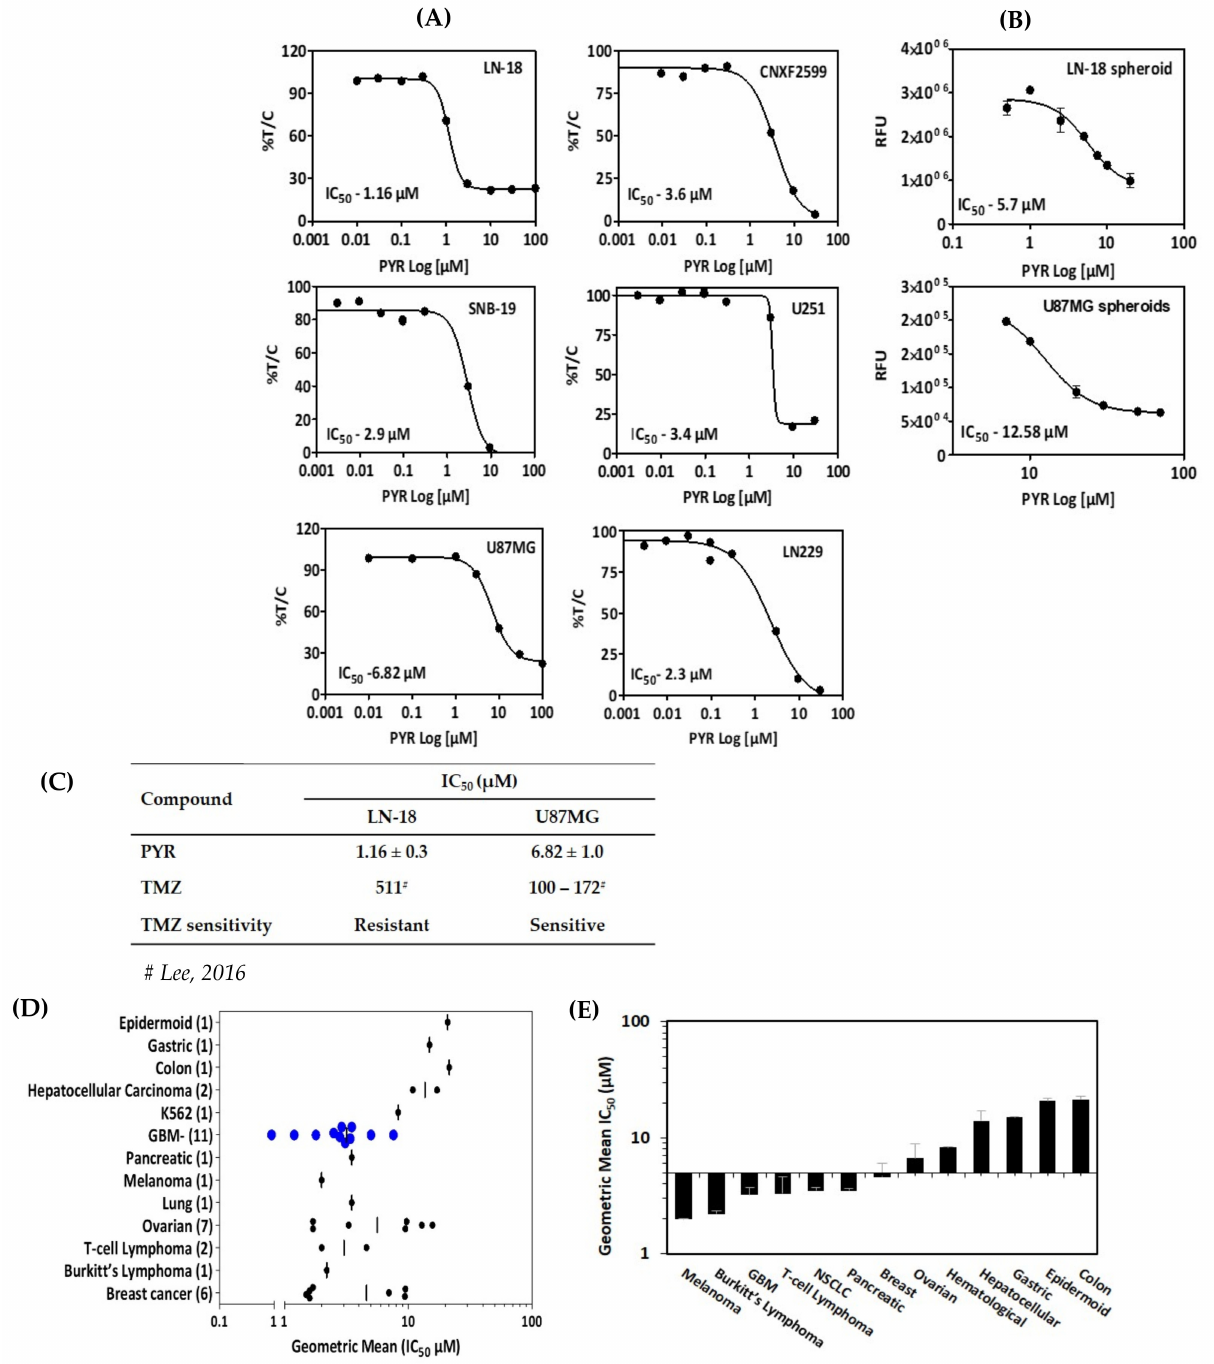
Figure 1. ( A ) In vitro cytotoxicity (IC 50 ) of PYR in a panel of six GBM cell lines at 72 h. CNXF-2599 is a patient-derived xenograft (PDX) cell line isolated from a male patient with unknown differentiation. Cytotoxicity is expressed as % survival (% T/C) as a ratio of treated by control. ( B ) Activity of PYR in 3D multicellular spheroids (MCS) or gliospheres generated from GBM cell lines. LN-18 and U87MG cells were seeded in triplicates in 96 well-plates (4000 cells/well) with 1.5% agarose layered at